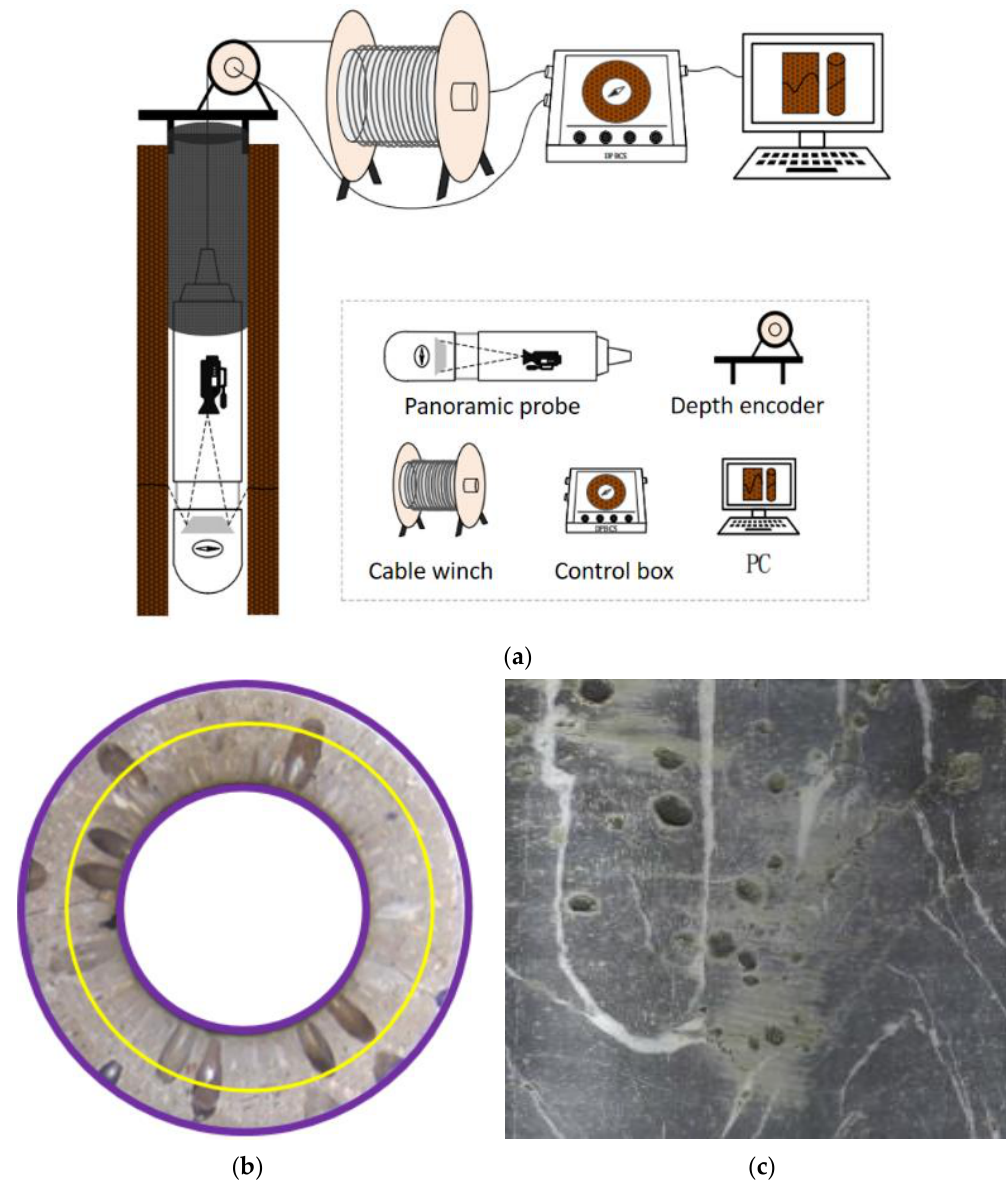
Figure 1. Schematic representation of the optical borehole image acquisition: ( a ) schematic diagram of the equipment structure, ( b ) panoramic impact data, and ( c ) expanded image.